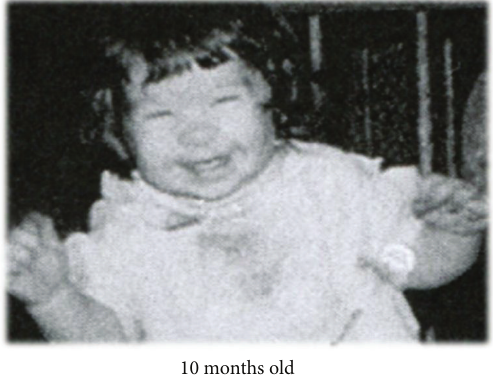
Table 1: Laboratory tests.